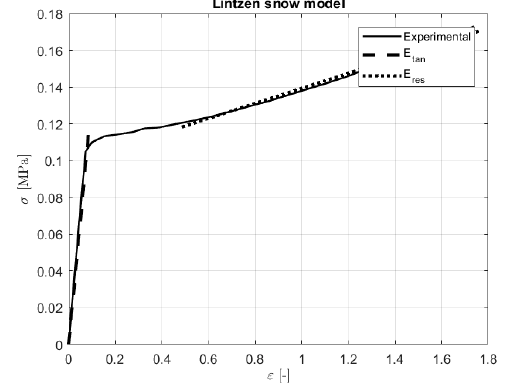
Figure 16. Snow model according to Lintzèn—adapted from [19].